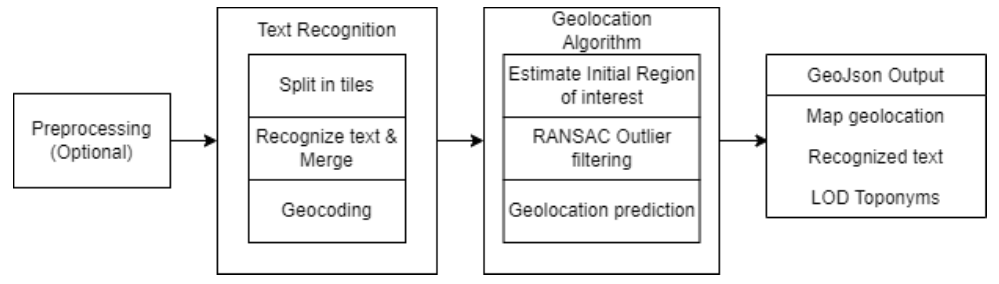
Figure 1. Overview of the entire